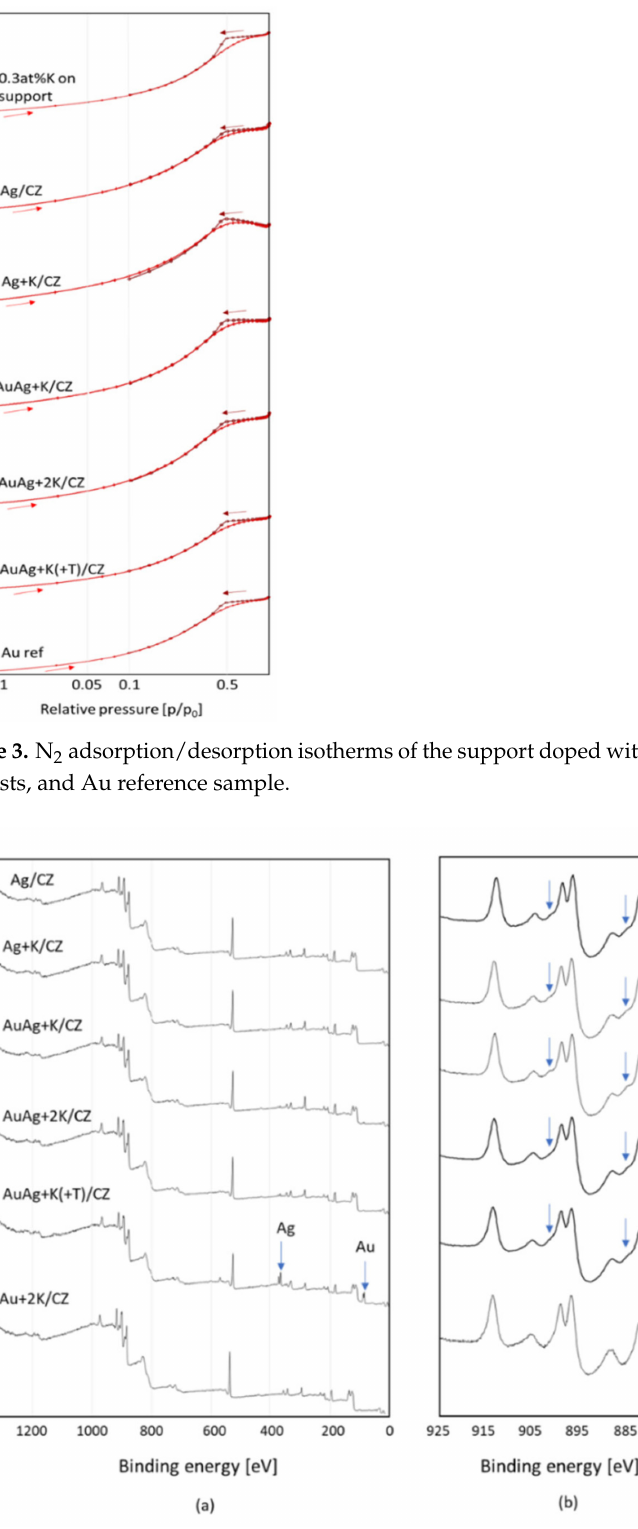
Figure 4. XPS results of all studied catalysts and Au+2K/CZ reference sample: ( a ) survey spectra and ( b ) Ce 3d detailed